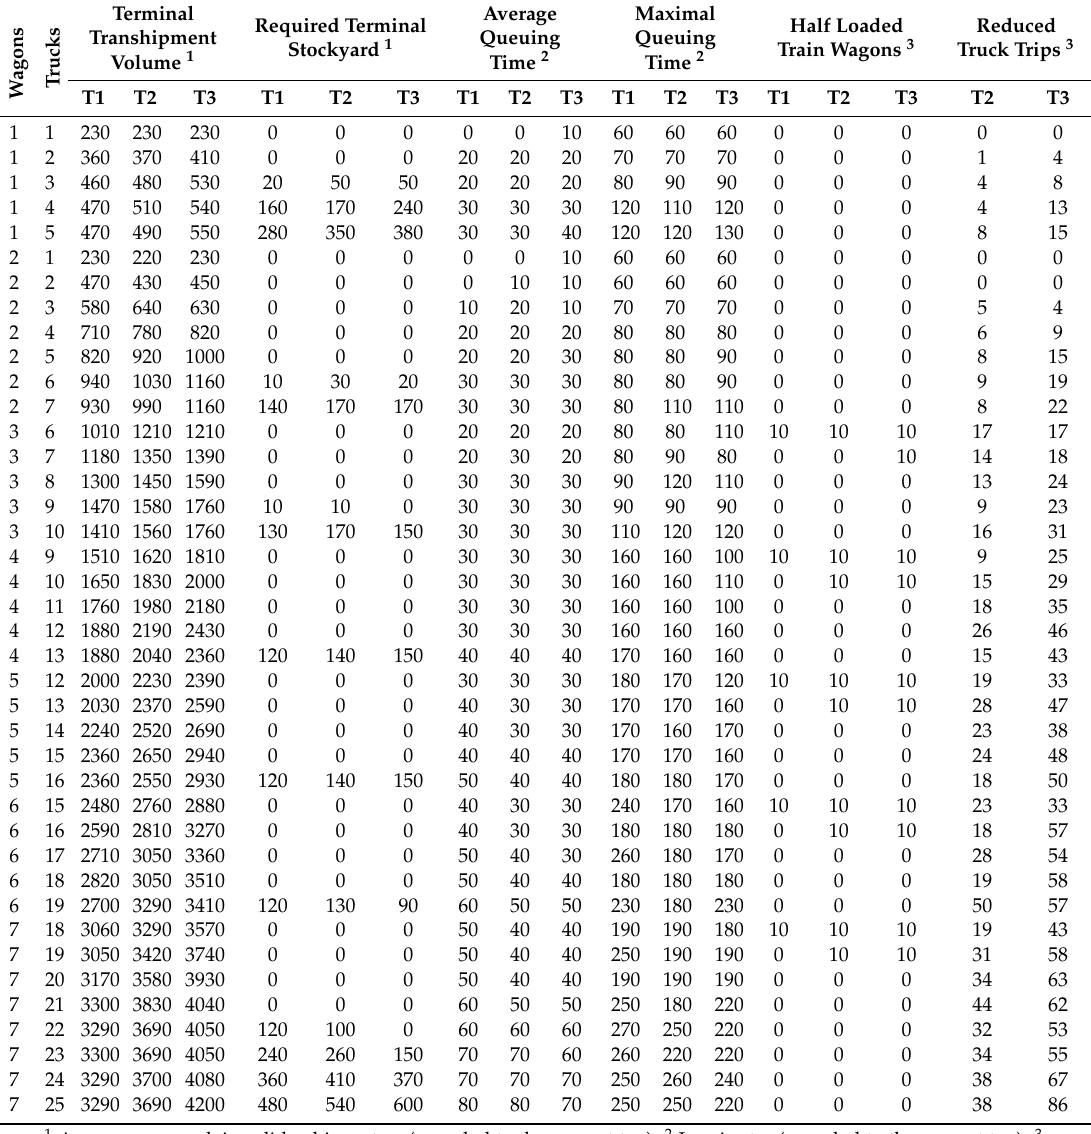
Table A6. Terminal transport template for two train pick-ups, long delivery time, and all tonnages (P2D3 T1 / 2 /